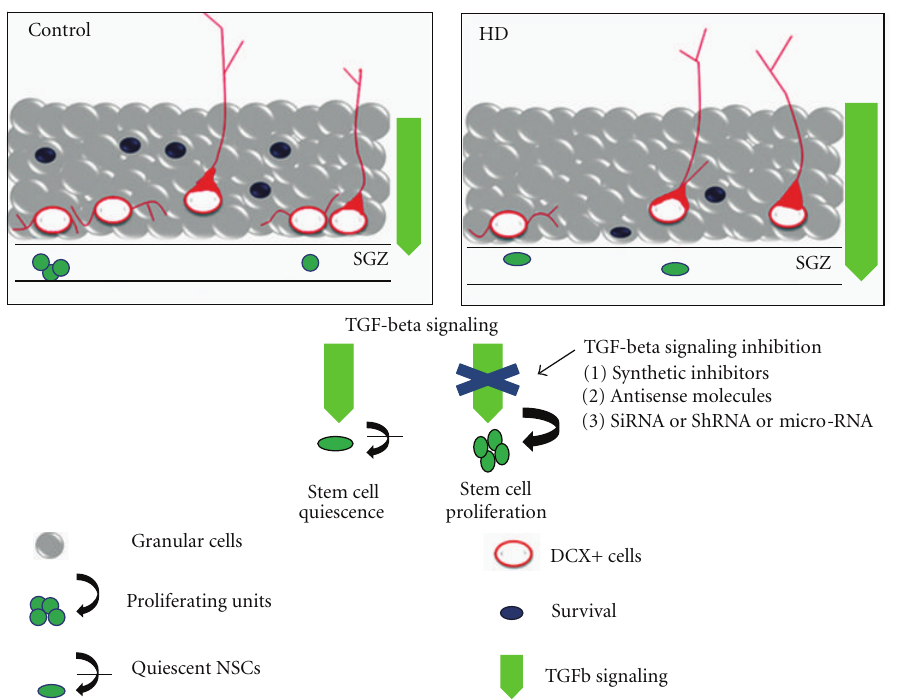
Figure 2: Schematic Illustration: The regulation of neural stem cell niche by TGF-beta1 signaling in tgHD rats. In tgHD rats (HD), the reduced proliferation of NSC (round-shaped green cells) is accompanied by a reduced number of DCX positive cells (red cells) and surviving newly generated cells (round-shaped dark blue cells) compared to control. The number of label-retaining quiescent NSCs (oval-shaped green cells), however, is increased in HD. In control, TGF-beta1 signaling (fluorescence green arrow) is confined to cells of GCL layer (gray cells) and is absent or low in the stem cell niche (SGZ: subgranular zone). In tgHD (HD), however, the overall TGF-beta1 signaling is elevated and in addition, prominent in the stem cell niche, where it accelerates cell cycle exit and NSC quiescence. Thus, inactivation of TGF-beta1 signaling in the stem cell niche might promote NSC proliferation and contribute to